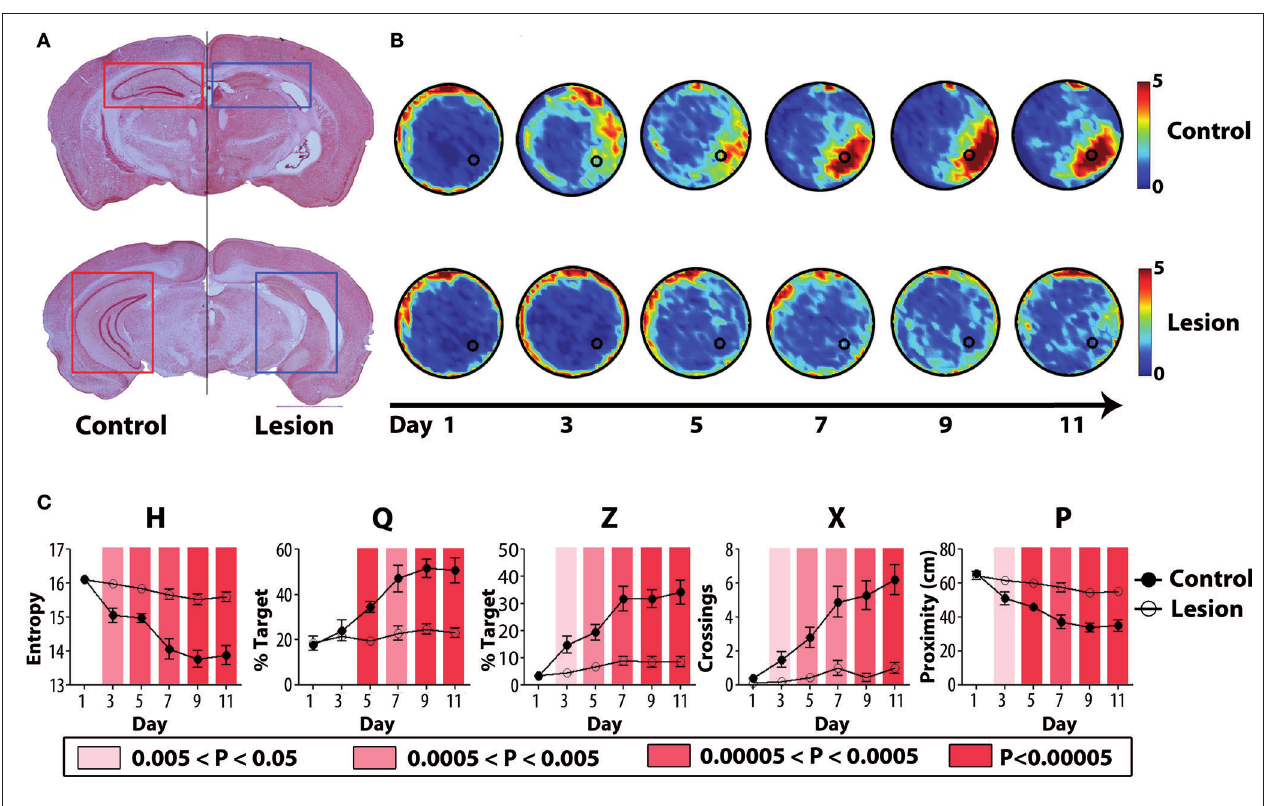
FIGURE 7 | Experimental validation of H (hippocampal lesions). (A) Representative coronal sections of the rostral (top) and caudal (bottom) hippocampus from control (left) and lesioned (right) mice. (B) Mice were trained for 11 days, with probe tests prior to training on days 1, 3, 5, 7, 9, 11. Density plots of probe test performance of control (top) and lesioned